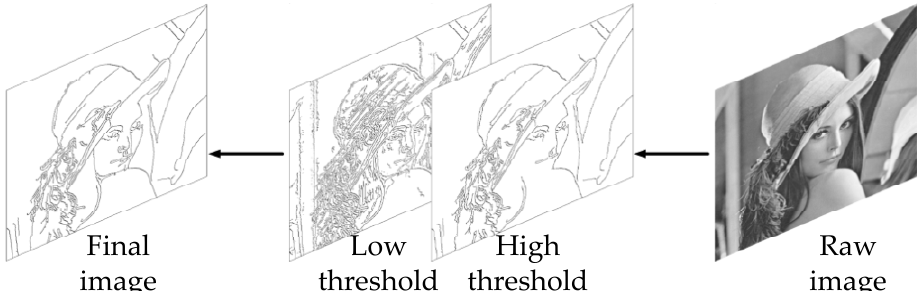
Figure 4. Improved Lena edge detection diagram.